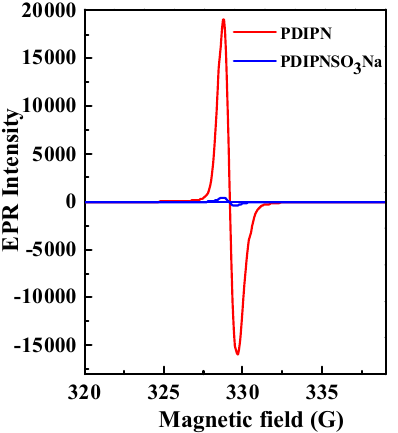
Figure 2. Electron paramagnetic resonance (EPR) spectra of the PDIPN and PDIPNSO 3 Na film.